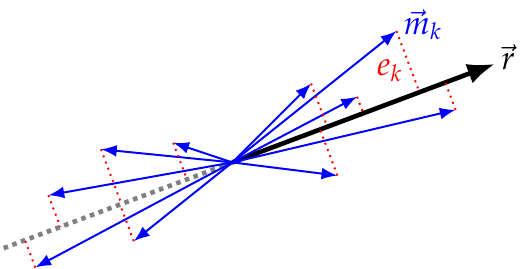
Figure 2. The set of relative angular velocity vectors (cid:126) m k projected onto knee axis (cid:126) r with resulting residuals e k . Note that for a perfect hinge m k (cid:107) (cid:126) r ∀ k however, due to imperfect hinge kinematics of the human knee and soft tissue perturbation of the gyroscopes mounted to the skin of the leg, the set of vectors (cid:126) m k takes this characteristic double cone